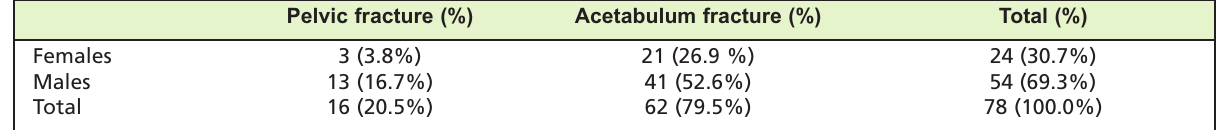
Patients with pelvic and acetabulum fractures based on gender Table I: